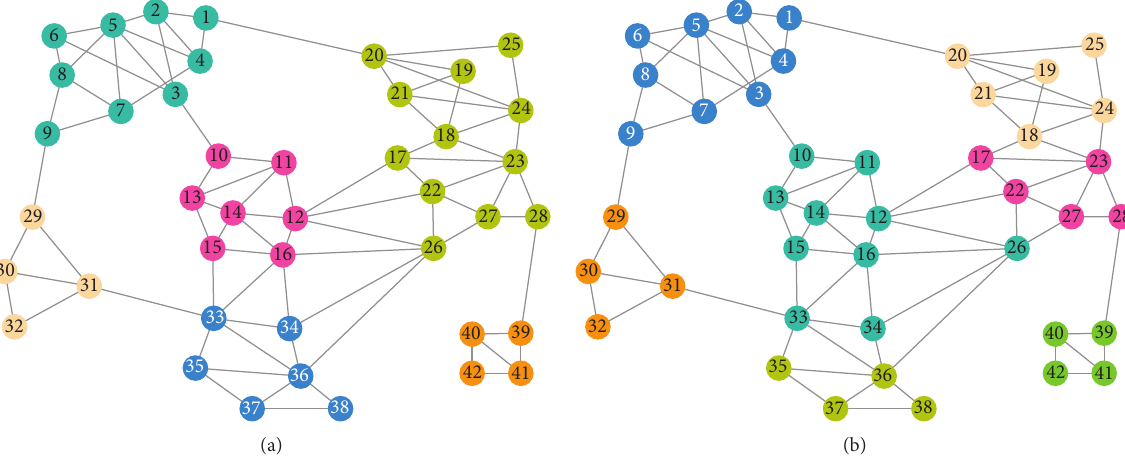
Figure 7: The Risk map network: (a) the ground-truth community structure; (b) the community structure uncovered by the proposed method.